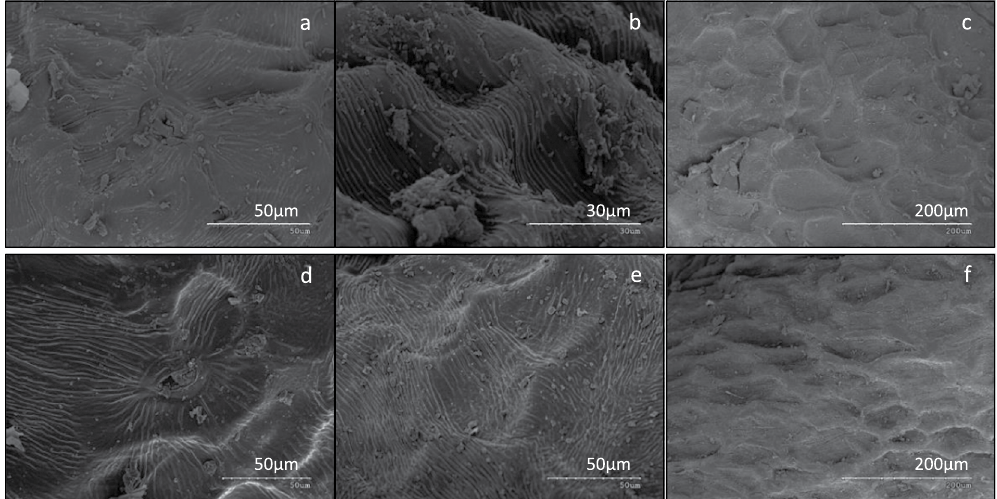
Figure 6. SEM surface images at different magnifications corresponding to untreated (up) and plasma treated nasturtium seeds (down) for 300